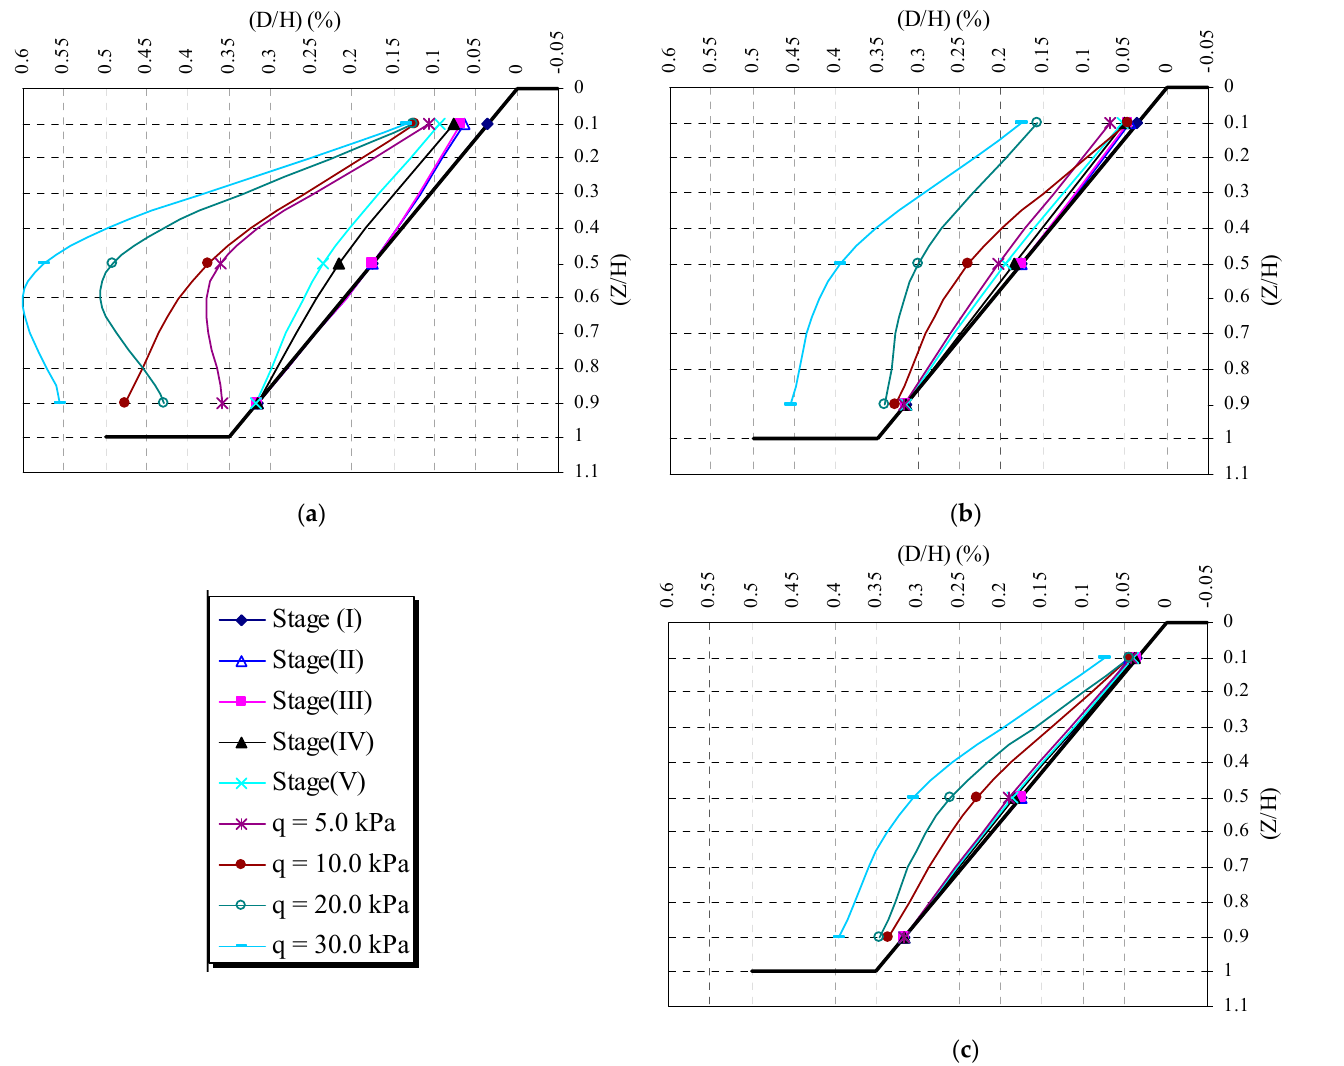
Figure 4. Influence of soil density on the horizontal movement of slope face in construction and loading stages; ( a ) loose sand; ( b ) medium sand; ( c ) medium sand.